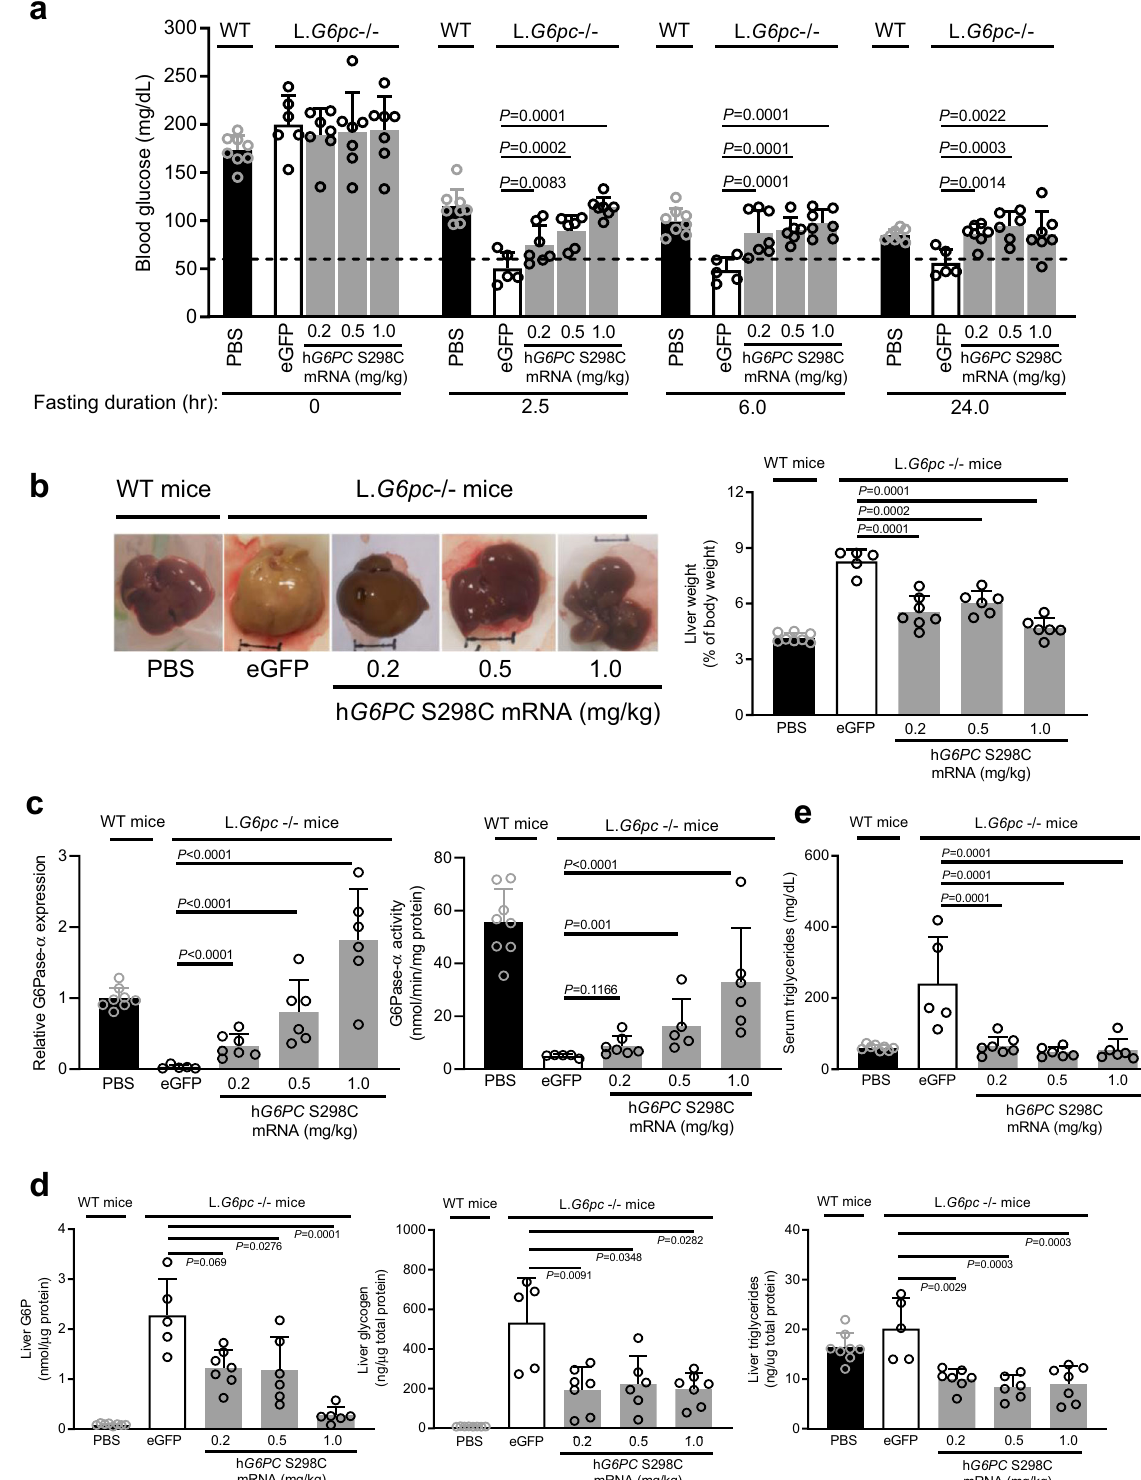
(Fig. 5b). L. G6pc − / − mice ( n = 7 – 9 per group) received fi ve consecutive injections of either eGFP mRNA or h G6PC S298C mRNA administered every 10 (second dose) to 14 days (all other doses) for over a period of 8 weeks. The mRNA was dosed at 0.25 mg/kg (Fig. 5b). Based on the single-dose ef fi cacy studies (Figs. 4a and 5a), the 2.5-h post-fasting blood glucose level was determined to be equally predictive of ef fi cacy as the longer 6-h